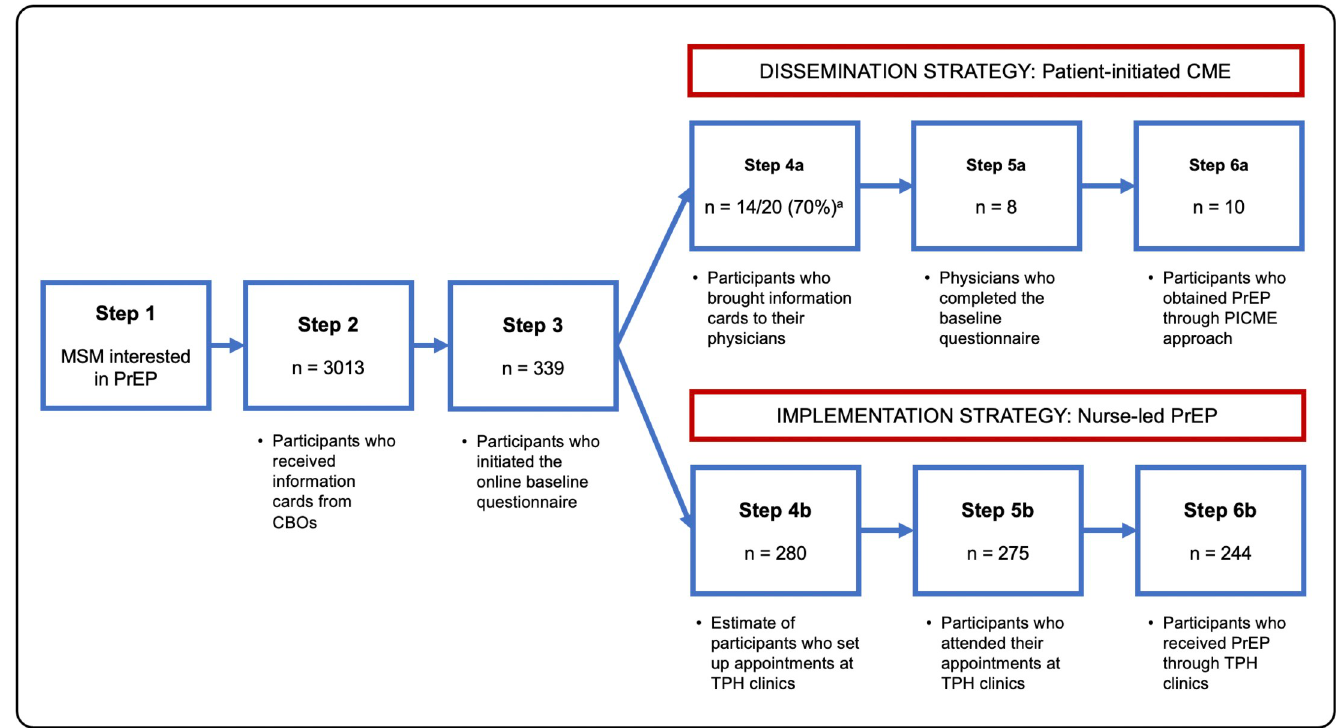
Fig 1. Number of participants who engaged with each step of the PrEP cascade. a A direct measure for Step 4a was unavailable, hence the number of completed follow-up questionnaires is reported here as the denominator.